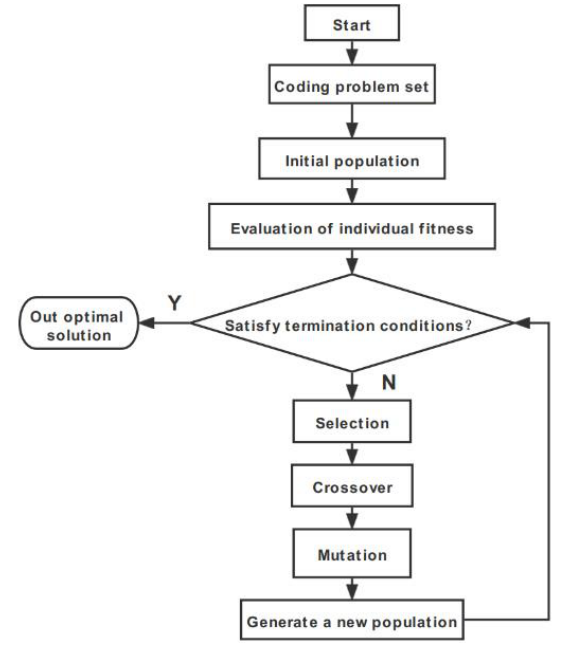
Figure 7. Flow chart of the genetic algorithm.